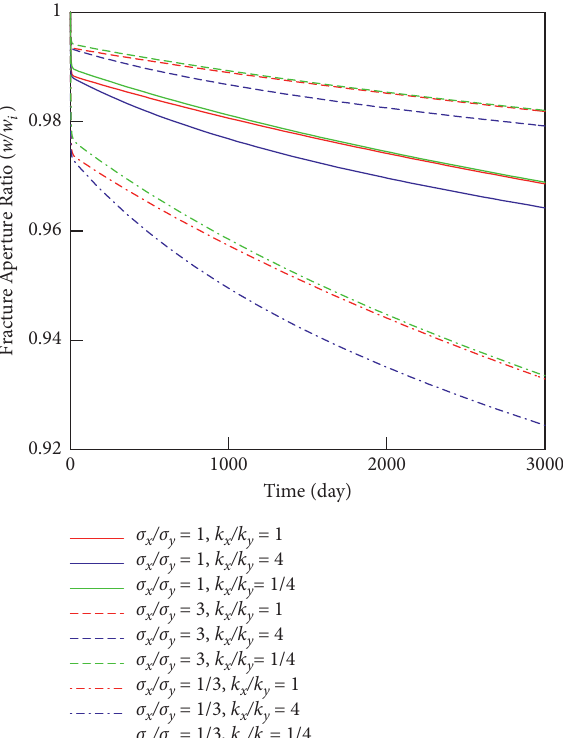
Figure 16: Fracture aperture history for fracture 1 with all the combinations of initial stress anisotropy and matrix permeability